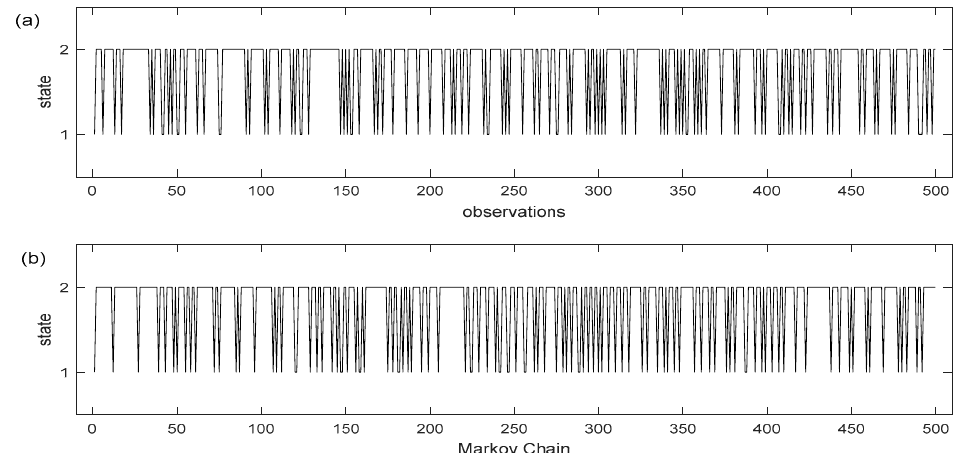
Figure 3. ( a ) Long term sequence of observation of the mosquito population process having two states, ( b ): realization of a Markov chain trained model on these observations, (state 1: low mosquito population, state 2: high mosquito population. Each time period corresponds to an observation for a finite number of successive seasons. The initial state at time 0 corresponds to the first observation made.